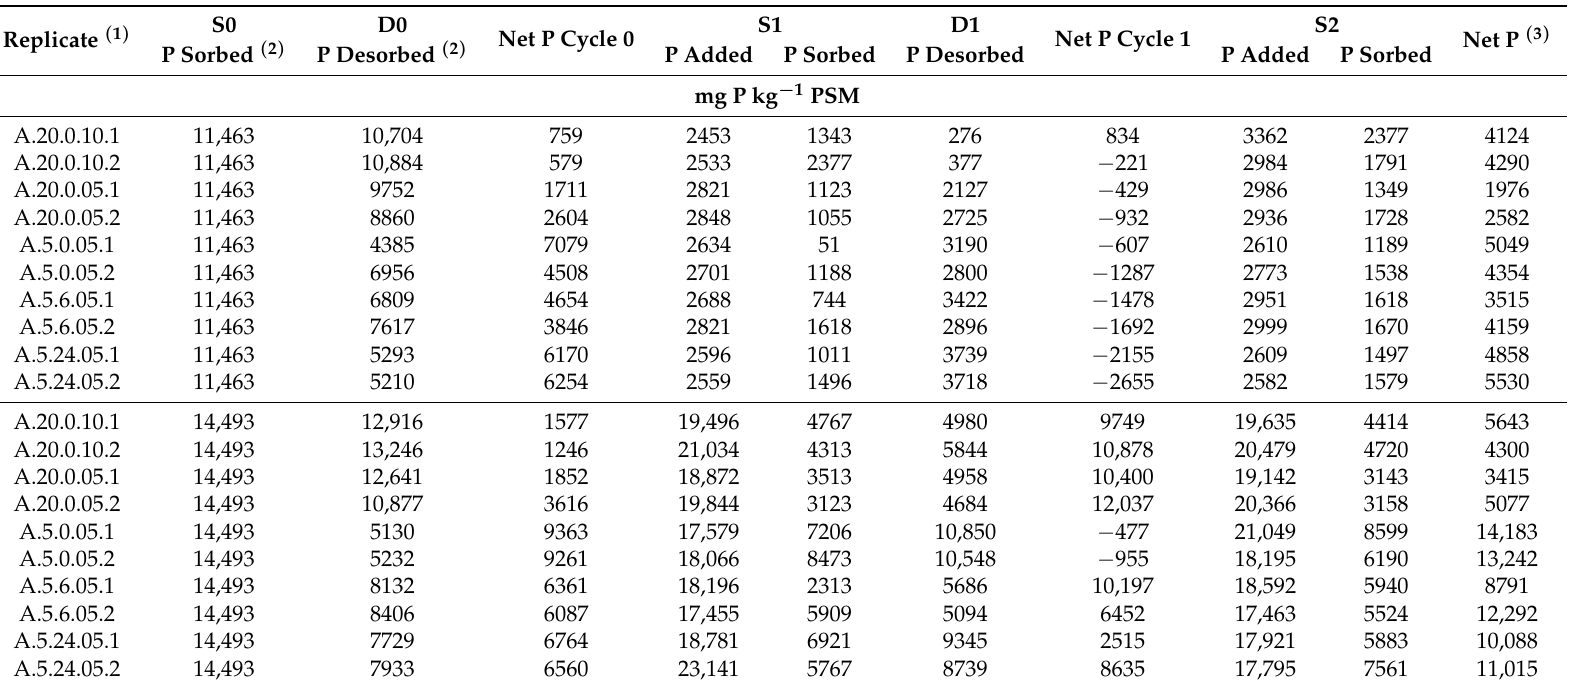
Table A1. Alcan Phosphorus (P) sorption and desorption results. Each row represents one regeneration treatment. The first ten rows refer to 0.5 mg L − 1 P, the second ten are 50 mg L − 1 P